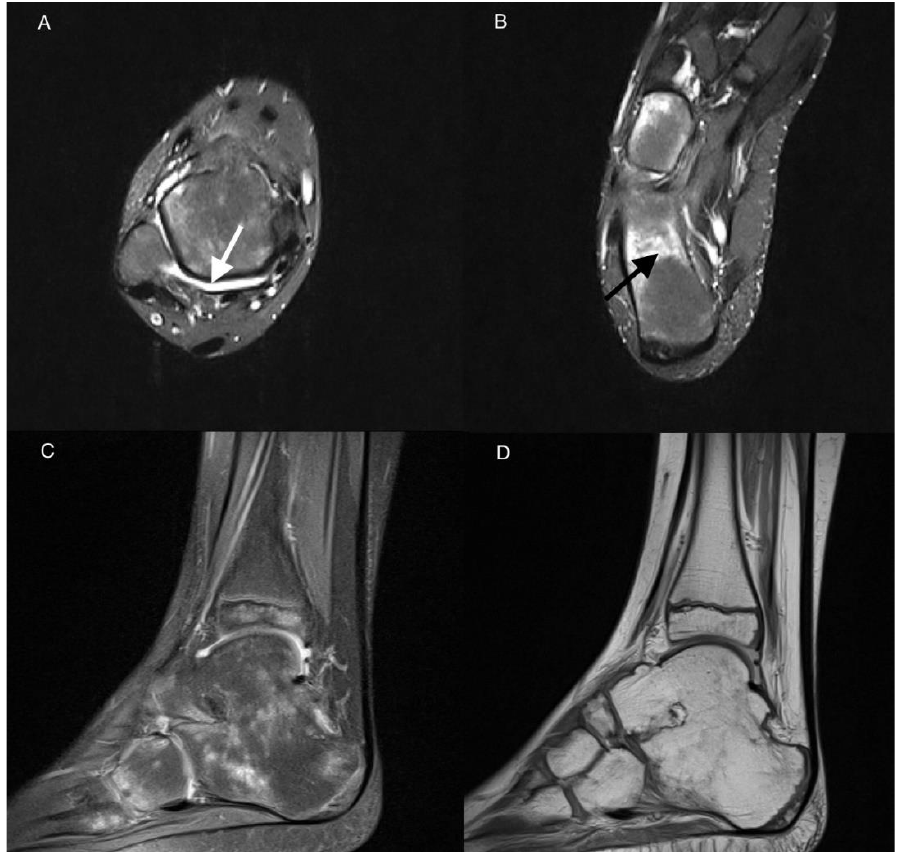
Figure 3. MRI of the right ankle of a 9-year-old boy with JIA. Axial T2-weighted TIRM images ( A , B ), sagittal PD with fat saturation ( C ), and sagittal PD-weighted image ( D ). Effusion/synovial thickening stage 2 in the tibio-talar joint (arrow). BME in numerous bones of the ankle and tarsum, the most advanced in calcaneus stage 3 (arrow in ( B )). Tibio-talar joint space narrowing, tibio-calcaneal ankylosis, and osteophytes ( C , D ).